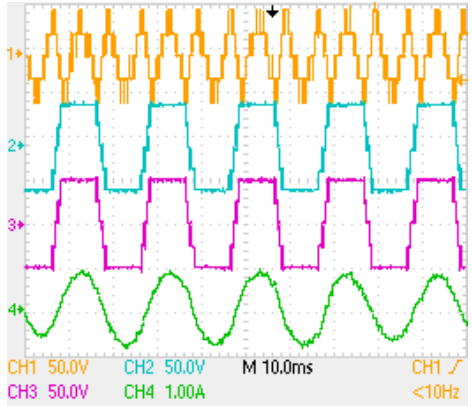
Figure 16. Switch states of Proposed strategy. (CH1: port voltage of Module 1; CH2: port voltage of Module 2; CH3: port voltage of Module 3; CH4: whole port voltage ).